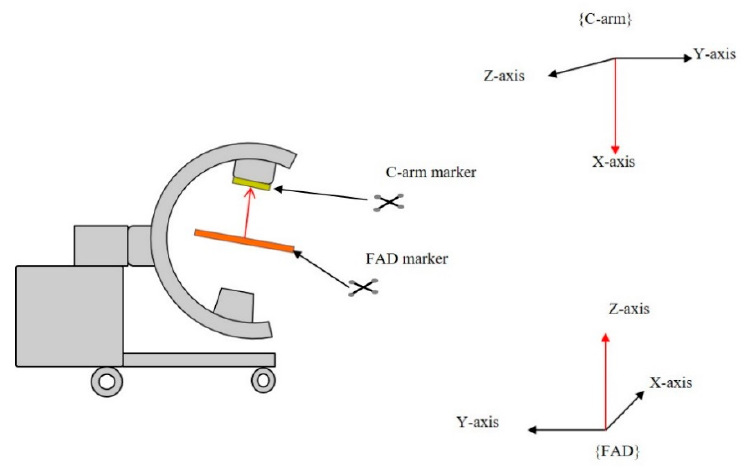
Figure 8. Measurement of angle error by OTS marker.